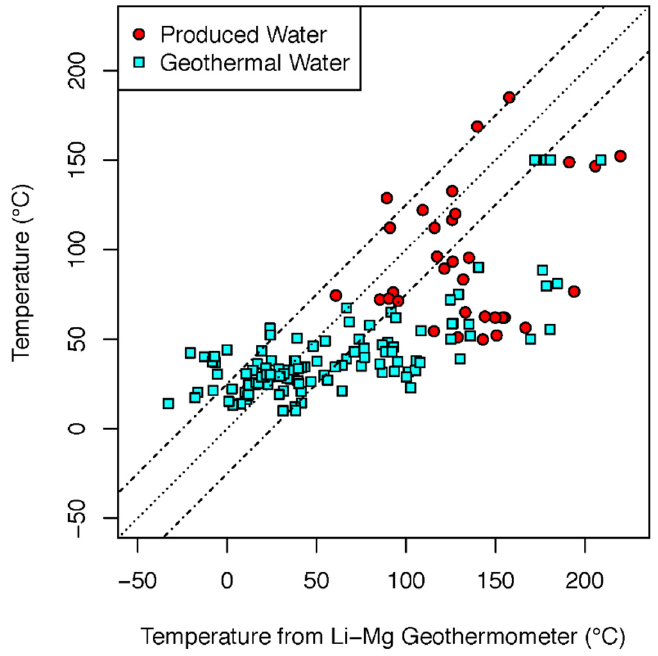
Figure 2. Reservoir and surface temperatures from produced and geothermal waters, respectively, from the input dataset versus temperatures estimated using the Li ‐ Mg geothermometer [32]. Dotted line shows 1:1 line and dashed ‐ dotted lines show 25 °C offsets from the 1:1 line.